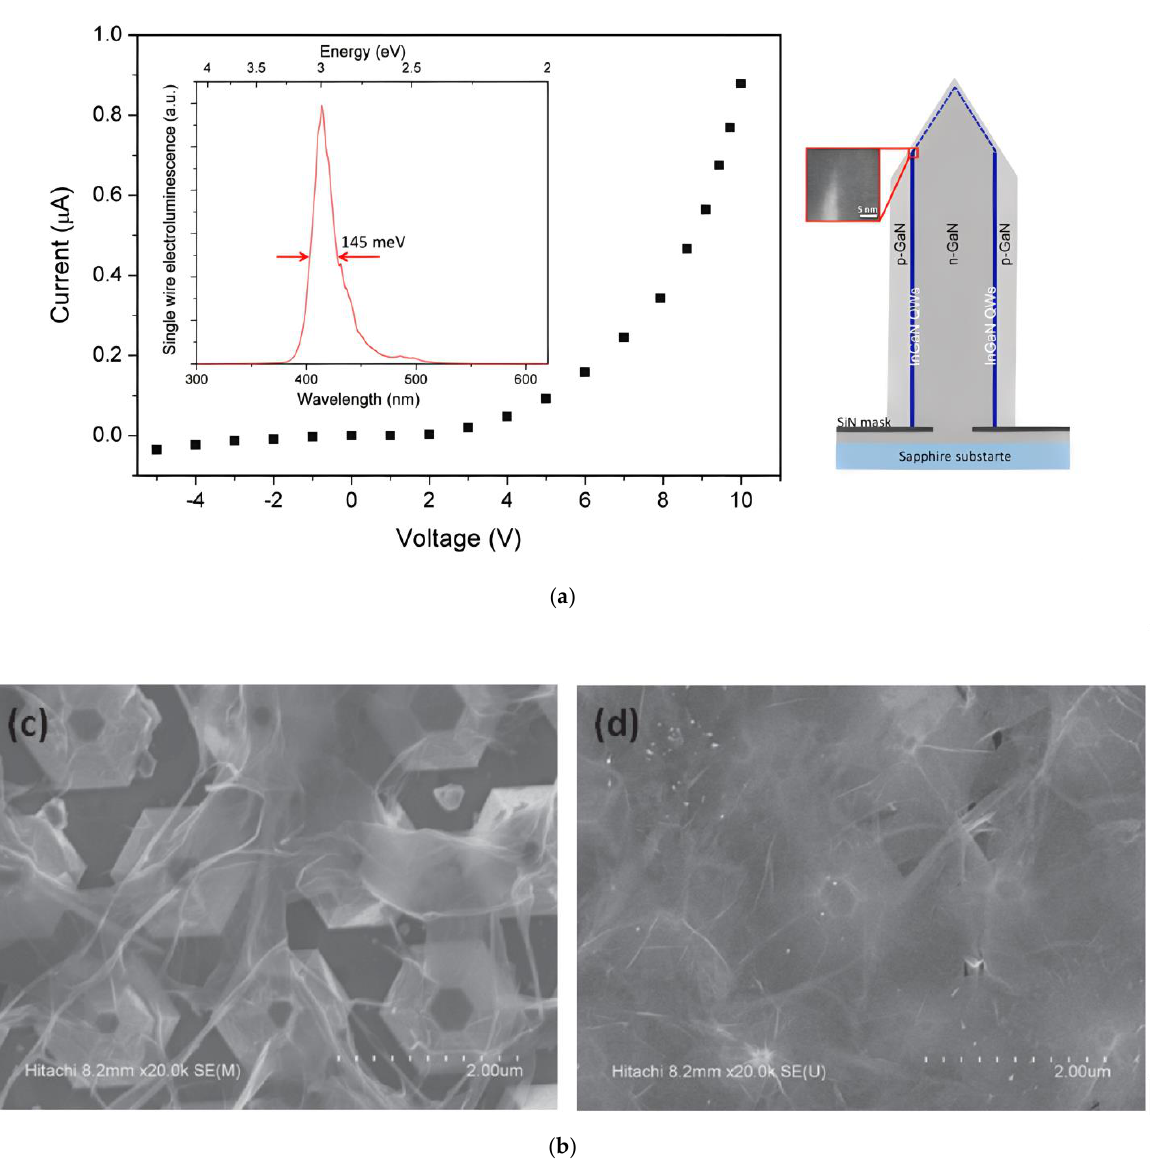
Figure 11. Graphene as TCSL in core-shell nanowire MQW LEDs: ( a ) EL (inset) and I-V characteristic (main plot) in a single nanowire LED with graphene (left) and schematic image of the nanowire structure (right); ( b ) SEM image of graphene transferred 3 (left) and 4 (right) times onto a large-area pyramid core-shell nanowire LED. ( a ) Reproduced with permission from [109]. Copyright 2014 American Chemical Society. ( b ) Reproduced with permission from [108]. Copyright 2013 The Japan Society of Applied